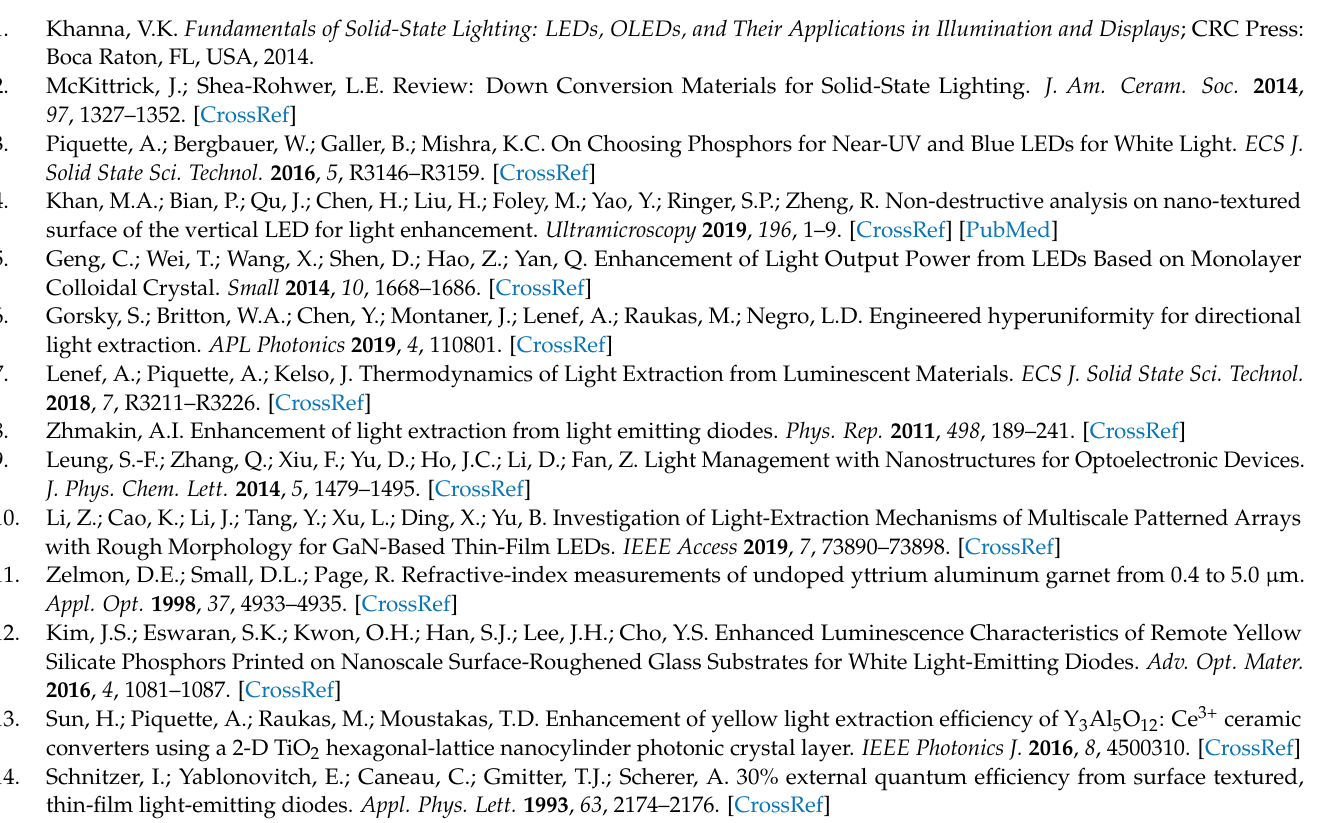
figuration used to excite samples on their front side; Figure S2: Schematic representation of the setup used to carry out angle-dependent photoluminescence by exciting samples on their back side; Figure S3: Cross-sectional SEM view of the ZnO NWs grown from a ZnO seed layer deposited on a bare silicon substrate; Figure S4: Example of binarized SEM image used to assess the area fraction occupied by ZnO NWs within the NWs array using ImageJ software. NWs appear as the white part of the